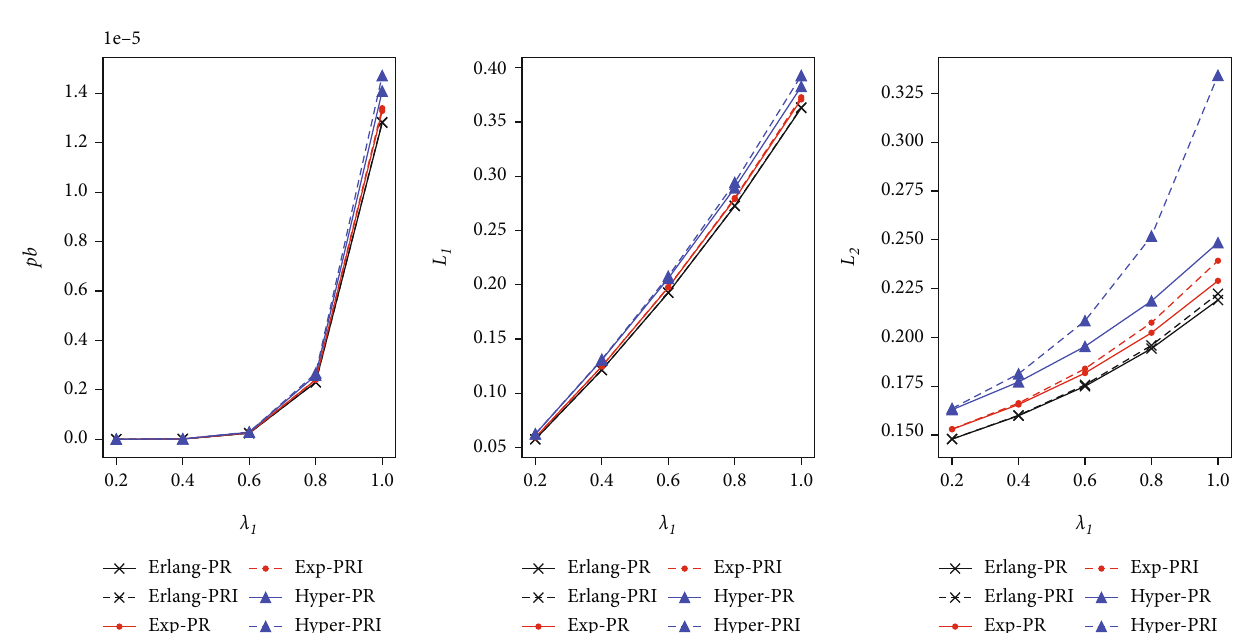
Figure 4: Performance measures for various values of λ